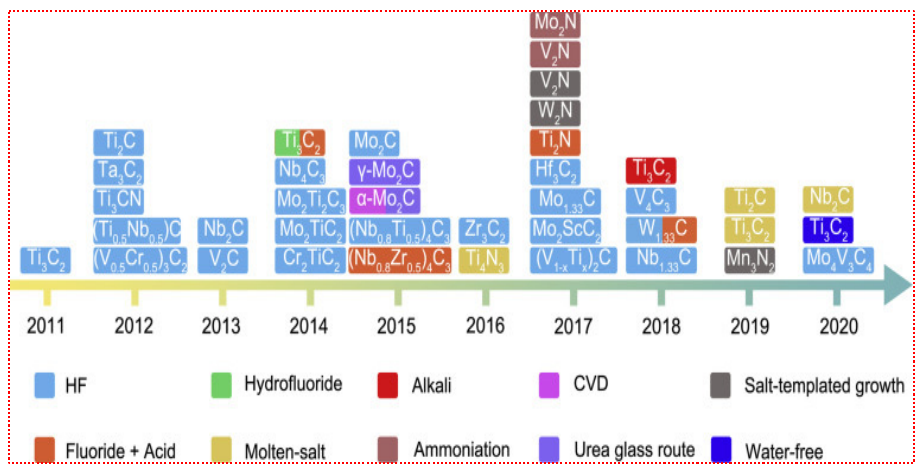
Figure 2. MXenes synthesis routes timeline in last decade. Reproduced with permission from ref. [31] Copyright 2021, Elsevier.